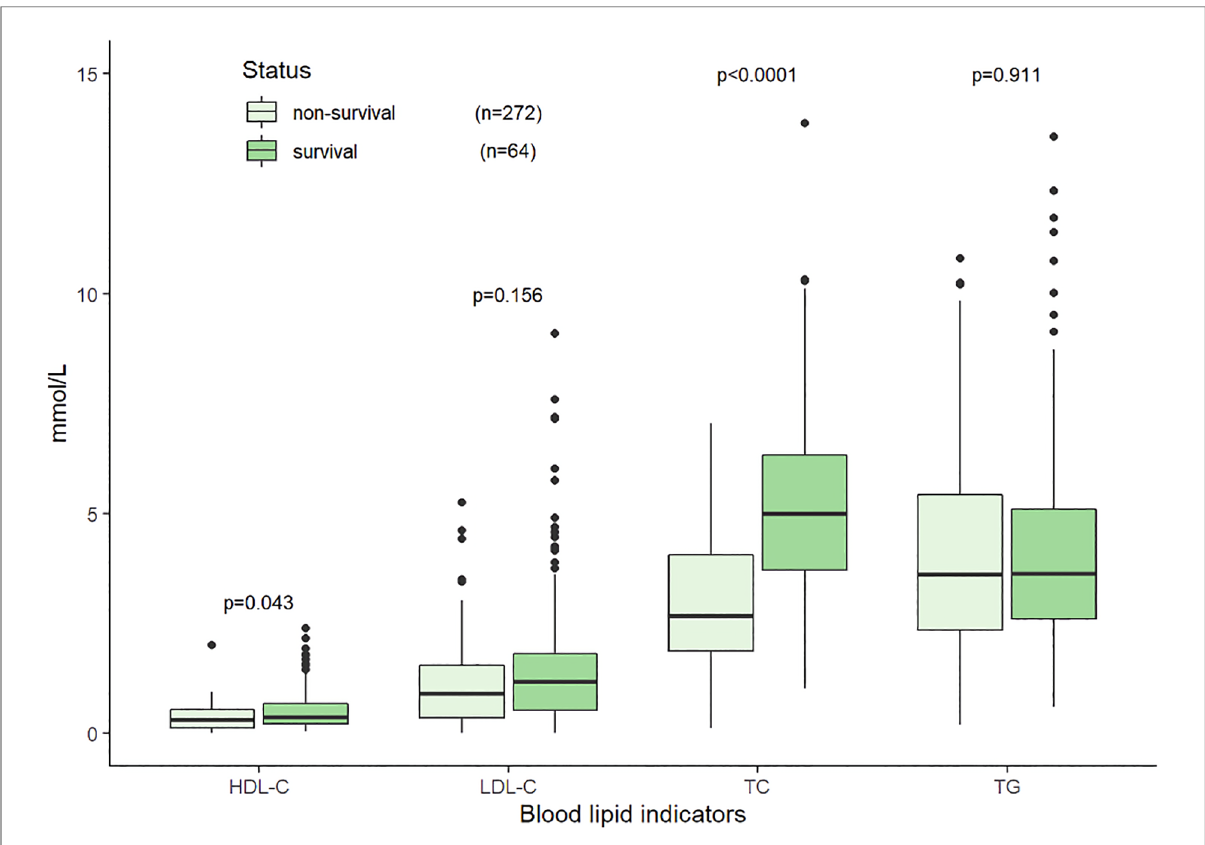
FIGURE 6 Distributions of blood lipid indicators at initial diagnosis in the non-survival and survival groups within 30 days in 336 HLH